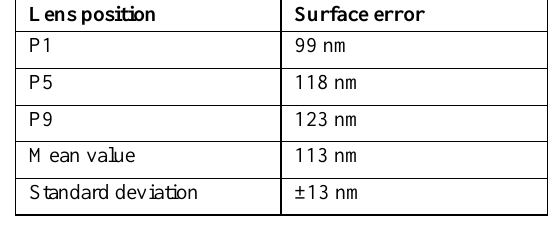
Tab 1. Measured rms surface deviation at three different lens positions.